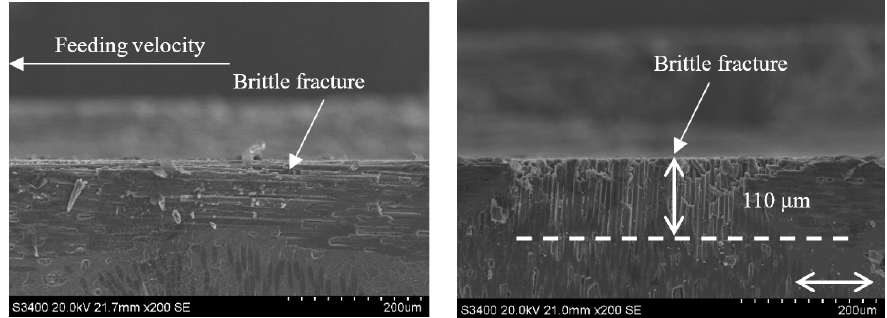
Figure 15. Grinding subsurface topography of the UAG-C/SiC composite (v s = 1.26 m/s, a p = 0.1 mm, v w = 100 m/min).